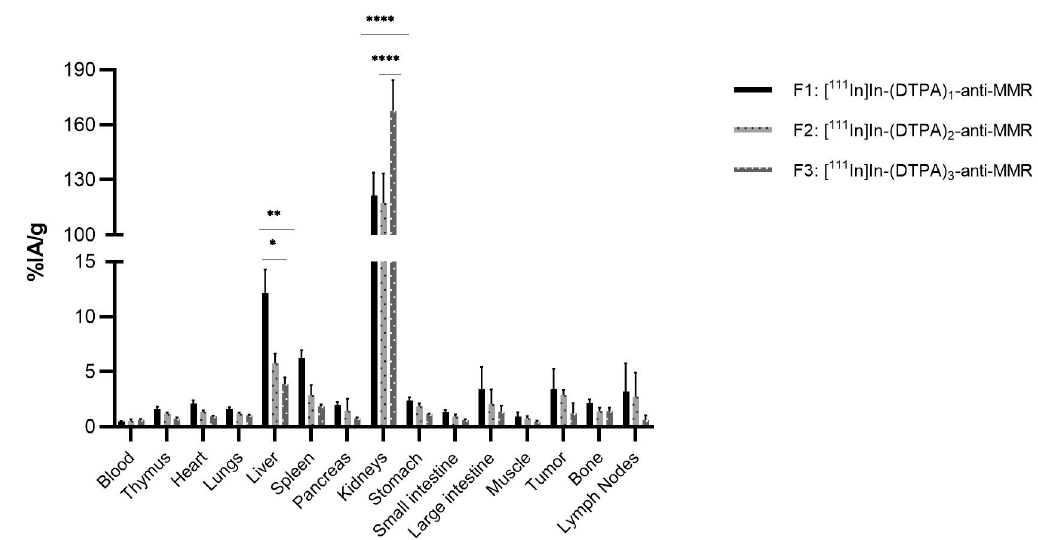
Figure 7. Ex vivo biodistribution analysis of [ 111 In]In-(DTPA) n -anti-MMR fractions in C57Bl/6 mice ( n = 6 per group), with a resistant LLC tumor variant. (* p < 0.05, ** p < 0.01, **** p < 0.001).